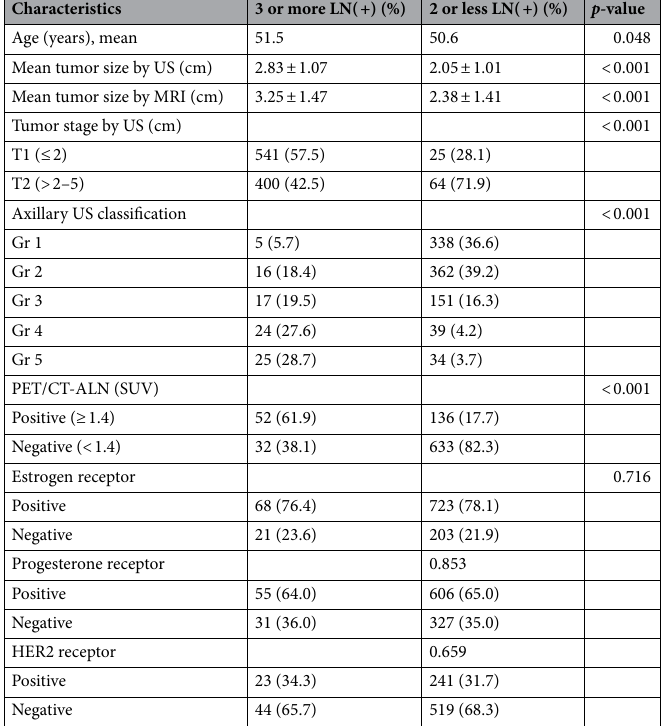
Table 2. Univariate logistic regression analysis for factors associated with involvement of three or more axillary lymph nodes. Values are presented as mean ± standard deviation or number (%). Abbreviations: ALN , Axillary lymph node; LN , Lymph node; US , Ultrasonography; Gr , Grade; MRI , Magnetic resonance imaging; PET/CT , Positron emission tomography/computed tomography; HER2 , Human epidermal growth factor receptor 2.